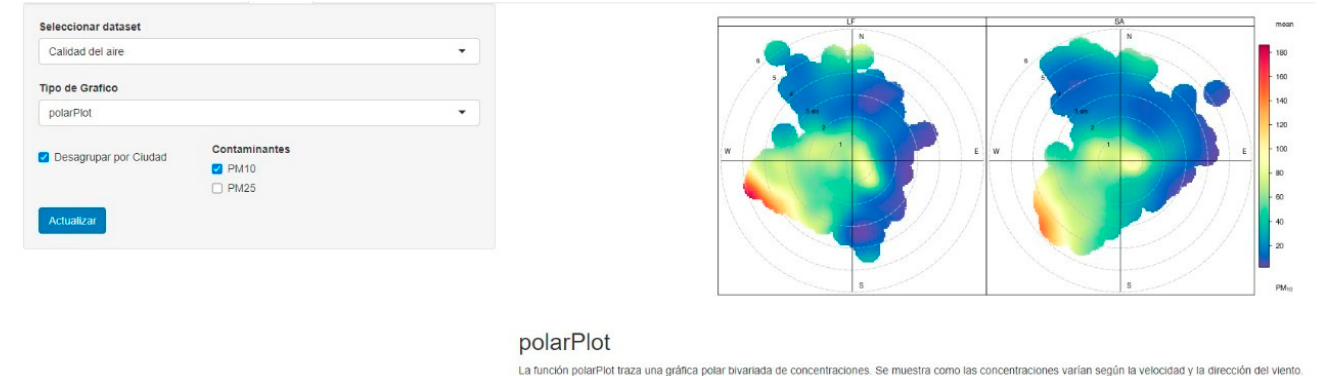
Figure A6. PM25 Polar Plot for the monitoring stations La Florida (LF) and Parque O’Higgins (SA).